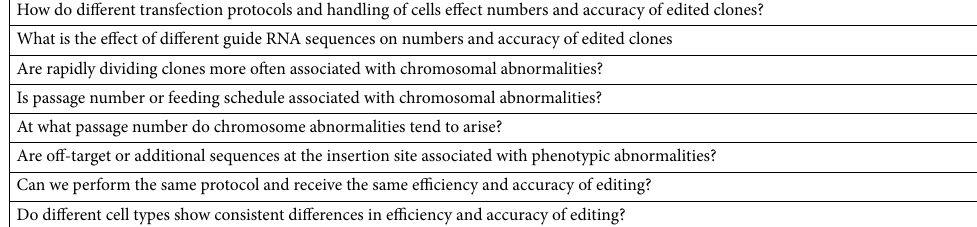
Table 1. Examples of questions for possible data queries to guide the collection of experimental